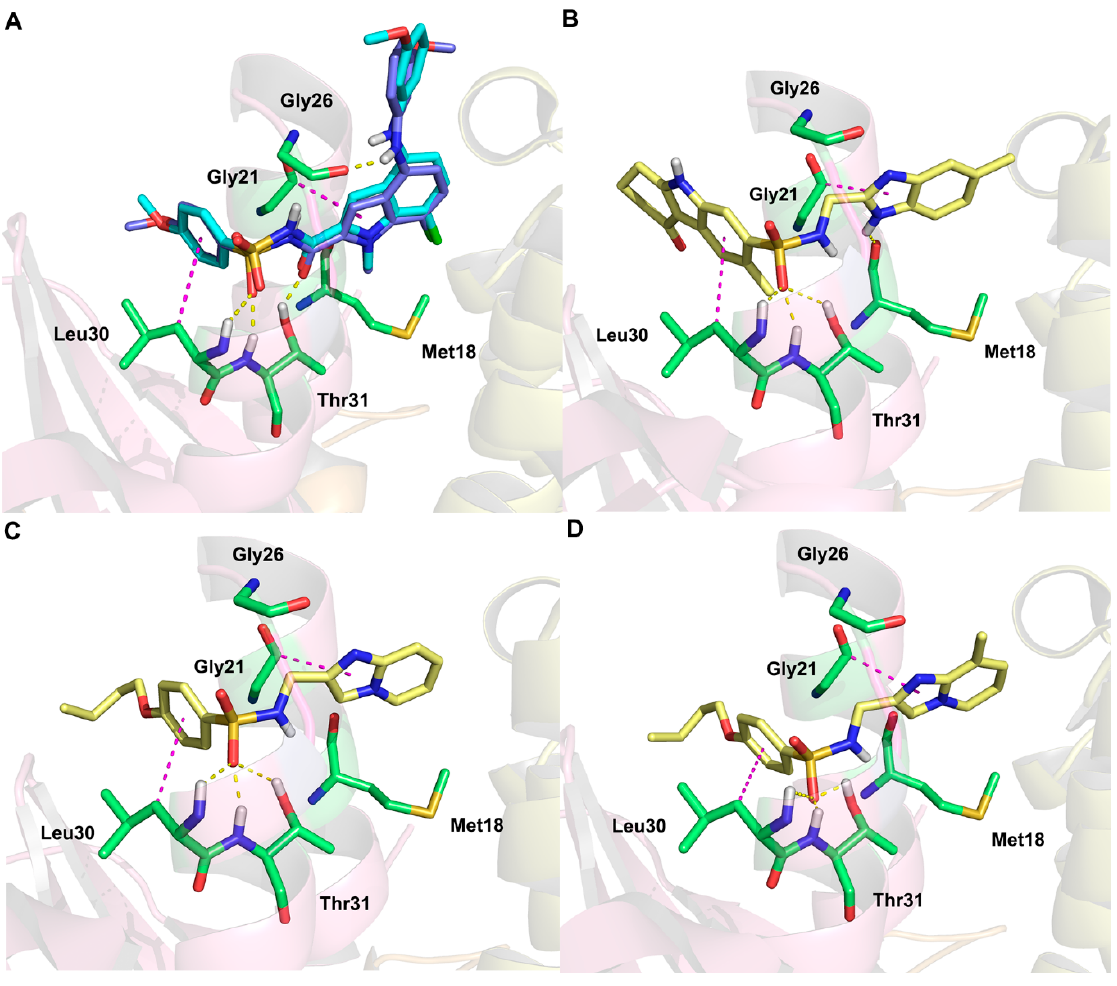
Figure 6. The docking results of compound 75 ( A , superimposition by its cognate structure), VS01 ( B ), VS02 ( C ), and VS03 ( D ). The redocked ligand, co-crystallized ligand, H-bonds, and hydrophobic interactions are shown as blue sticks, cyan sticks, yellow dashes, and magenta dashes, respectively.